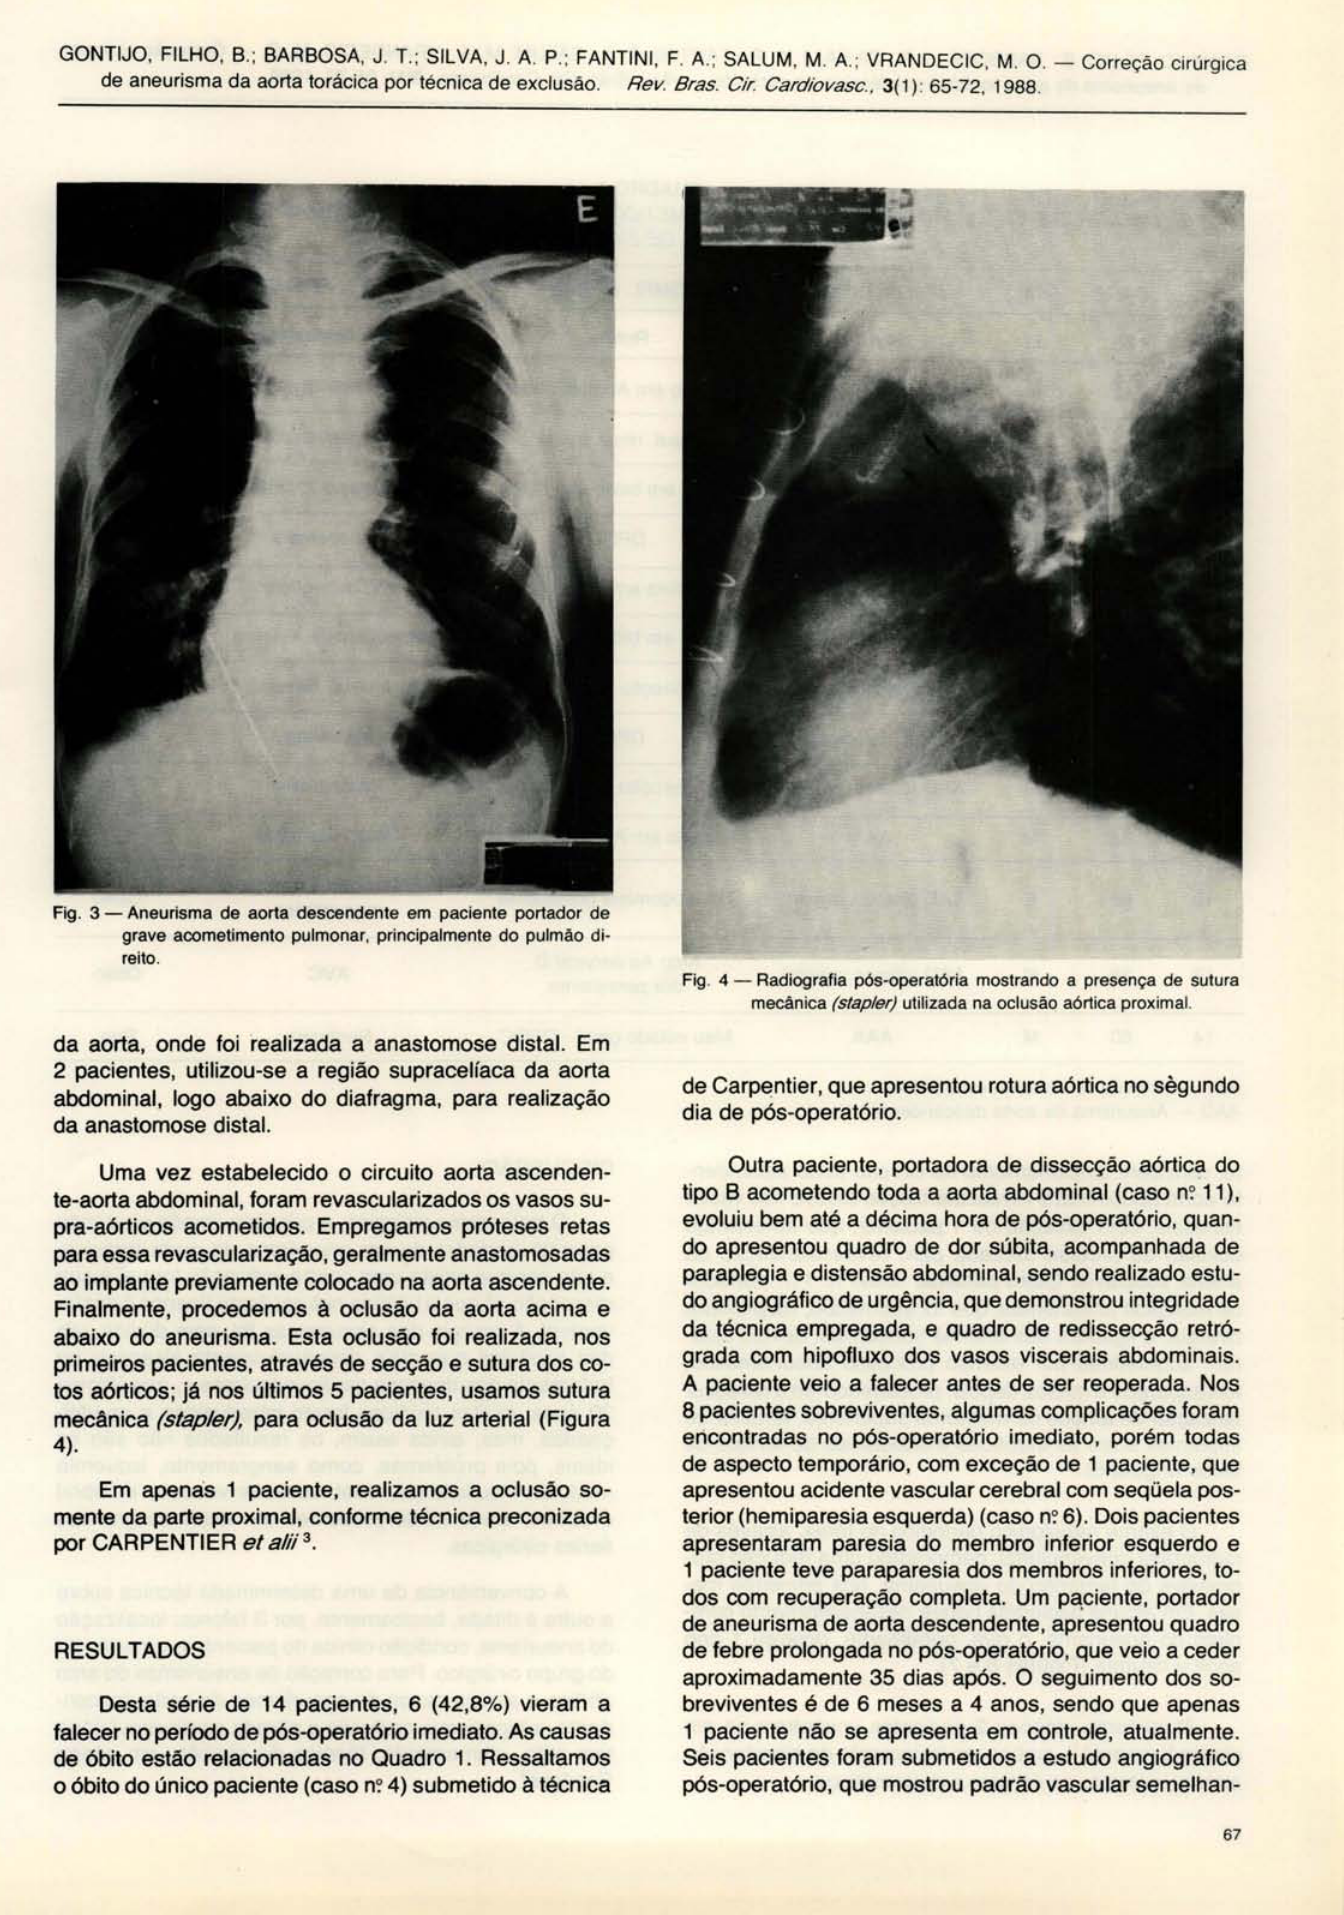
Fig. 3 - Aneurisma de aorta descendente em paciente portador de grave acometimento pulmonar, principalmente do pulmão di reito.